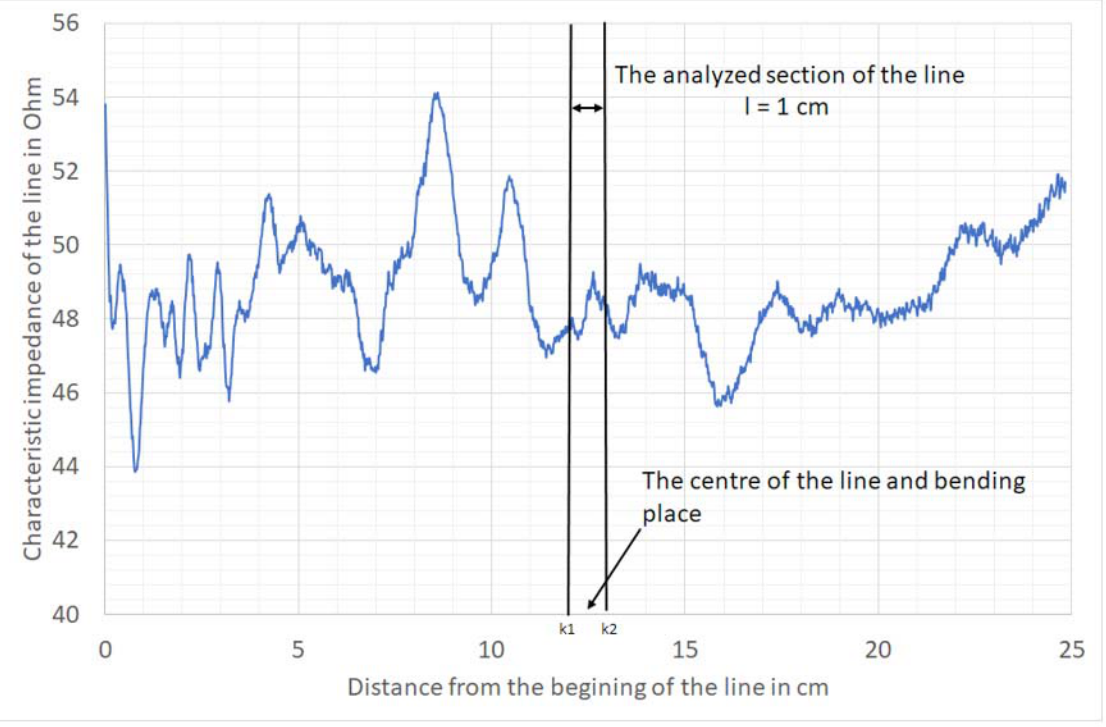
Figure 7. The average impedance profile of the F5 line with the Ponge substrate. Each obtained impedance profile is composed of n points. The bending place was the middle of the line. The middle section of the line, l = 1 cm long, was further analysed. To do this, from the n values of the characteristic impedance of the impedance profile, k values corresponding to the interval of length l (Figure 7) were selected. To perform statistical analysis, the average value and standard deviation of the characteristic impedance of this section were determined for each of the characteristic impedance profile measurements.